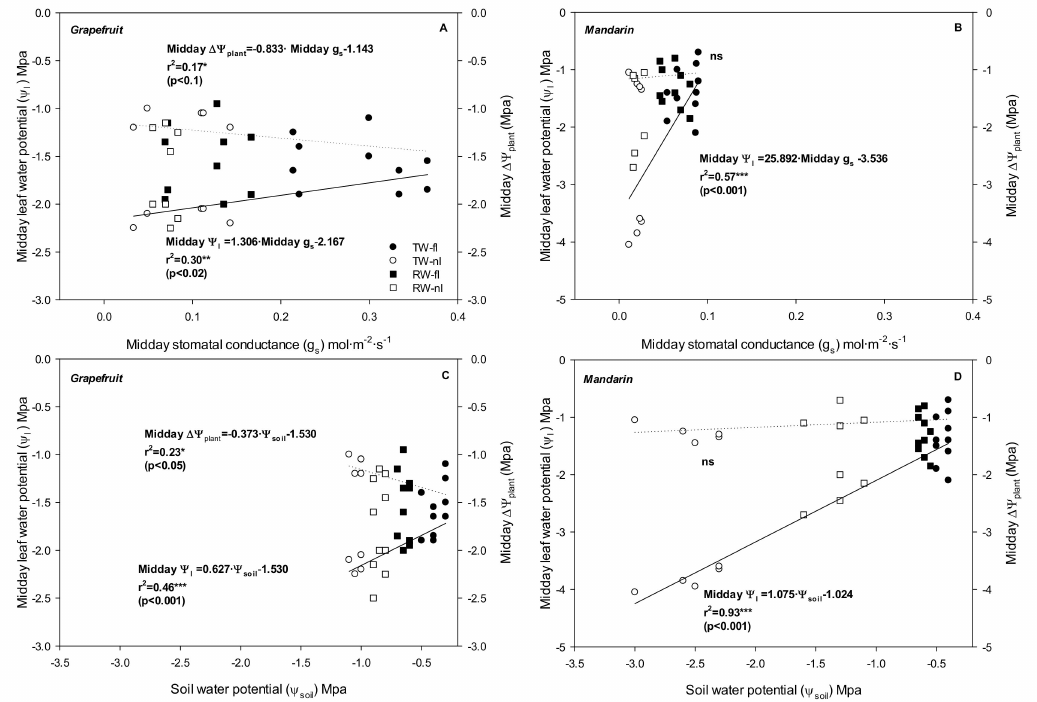
Figure 6. Correlations of midday leaf water potential (midday Ψ l ) with midday stomatal conductance (midday g s ) (continuous lines), of midday hydrodynamic (transpiration-induced) water potential gradient from roots to shoots (midday ∆Ψ Ψ Ψ plant ) with midday g s (dash lines) ( A , B ), and of midday l with soil water potential ( soil ) (continuous lines) and midday ∆Ψ Ψ plant with soil (dash lines) ( C , D ) for all treatments and both crops (grapefruit and mandarin). A positive relationship between g s and T l was found when only data below 30 ◦ C were plotted (r 2 = 0.51, p < 0.005 and r 2 = 0.27, p < 0.005 for grapefruit and mandarin, respectively). This was due to the fact that from 20 to 30 ◦ C, the VPD and T l were